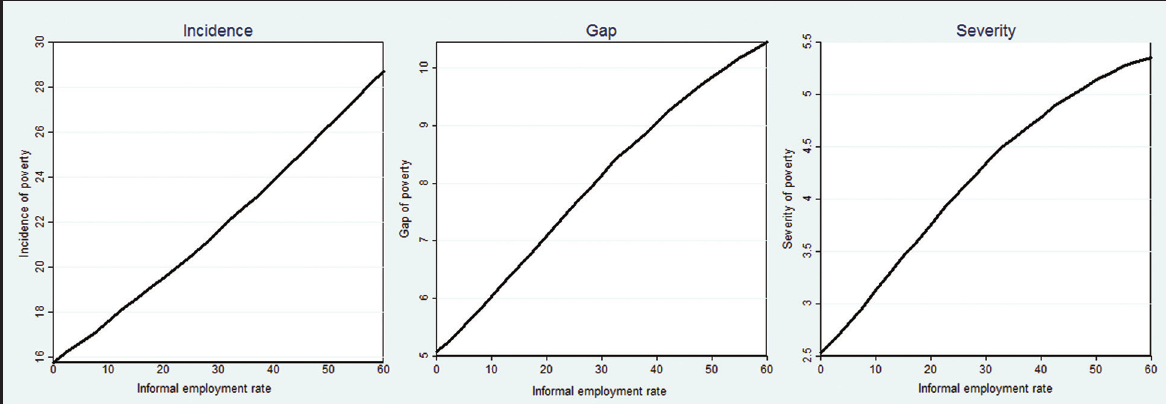
Continuous formalization and poverty indicators in Colombia.